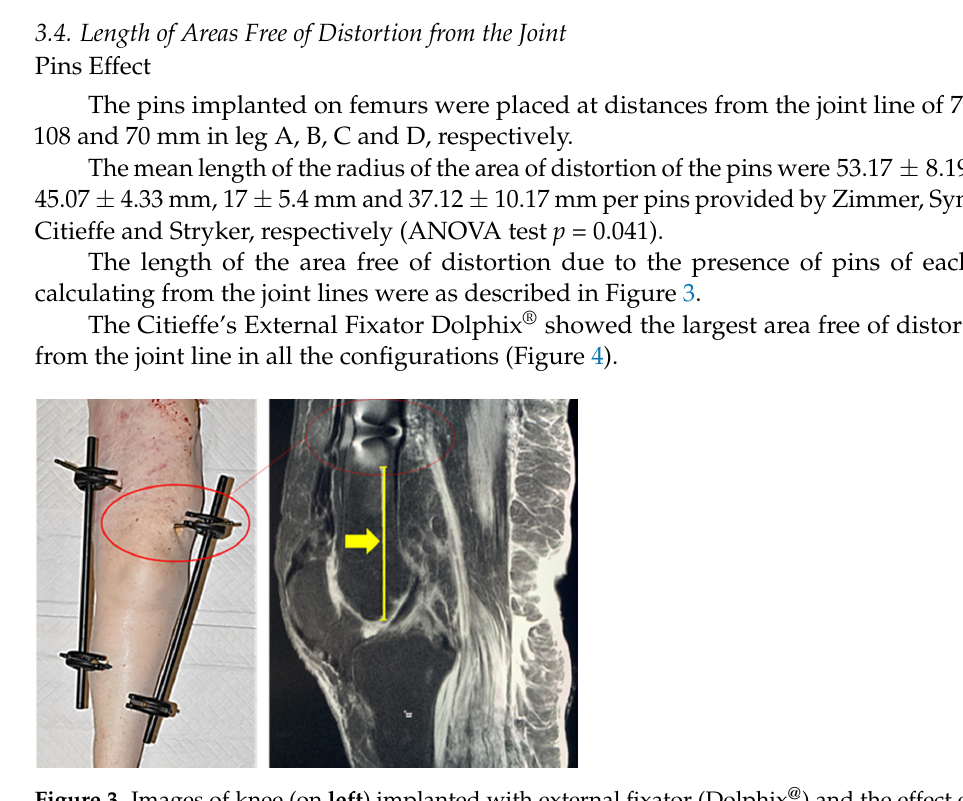
Figure 3. Images of knee (on left ) implanted with external fixator (Dolphix @ ) and the effect of pin underlined by circle on MRI images (on right ). The arrow indicates the light of area free of distortion from the pin to the joint line.